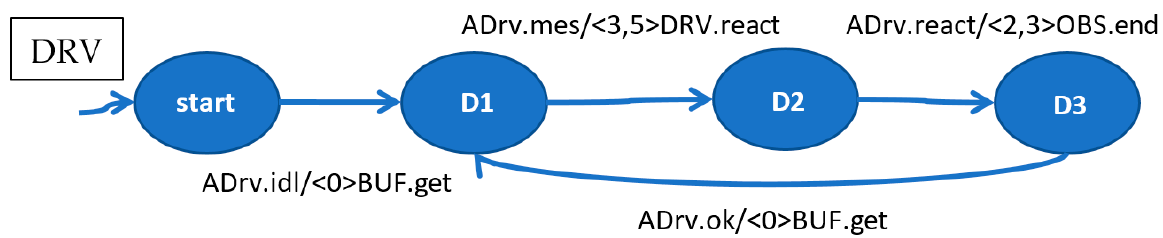
Figure 11. The automaton modeling the bu ff er, BUF.